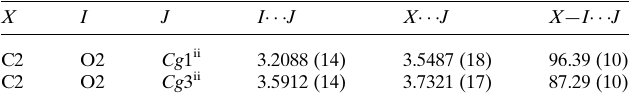
Table 1 Hydrogen-bond geometry (A˚ , (cid:4) ). Table 2 C—O (cid:2)(cid:2)(cid:2) (cid:3) interactions (A˚ , (cid:4) ). Cg 1 is the centroid of the O1/C1/N1/C5/C4 ring and Cg 3 is the centroid of the O1/C1/C5–C9 ring.